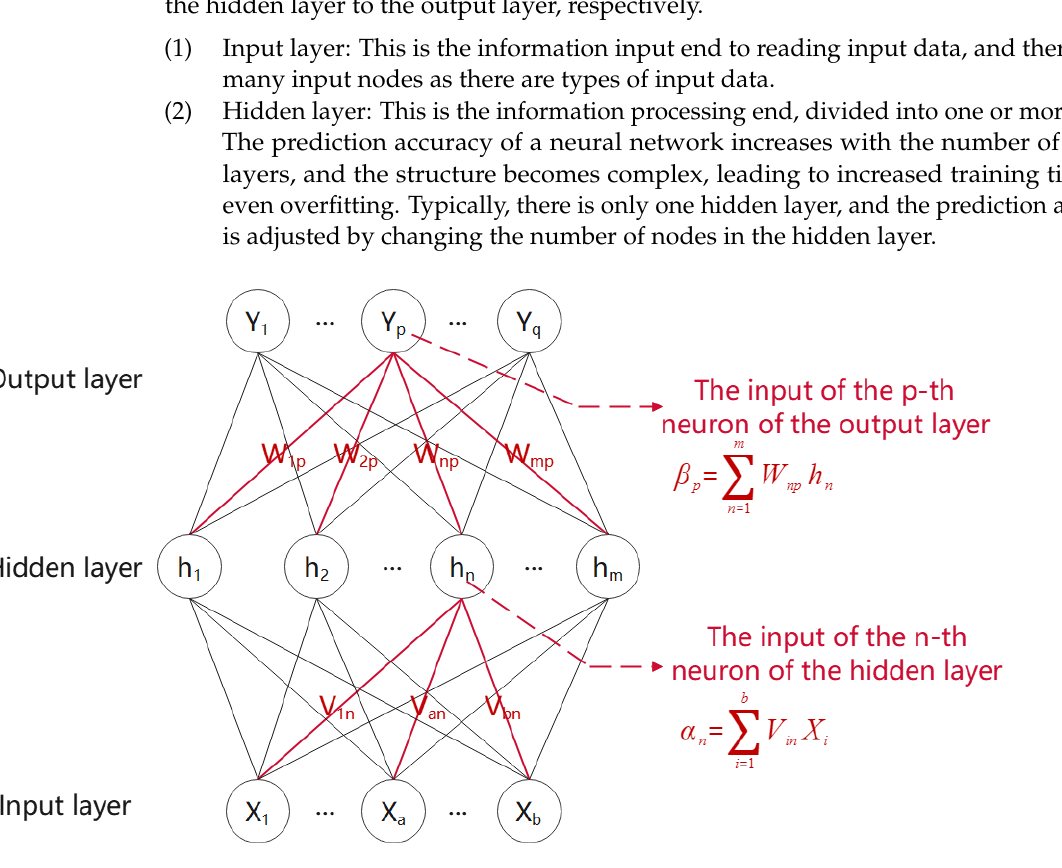
Figure 5. Basic structure of BP neural network.